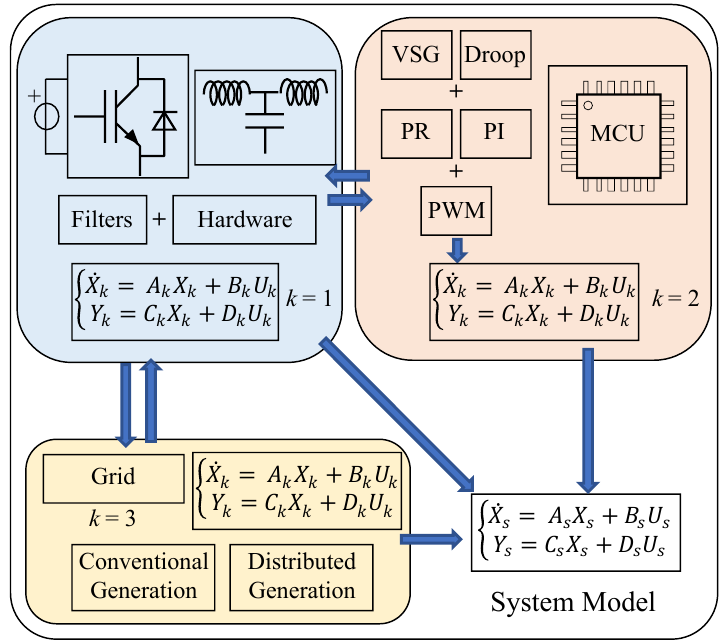
Figure 1. Modular state-space modeling of a grid connected converter including